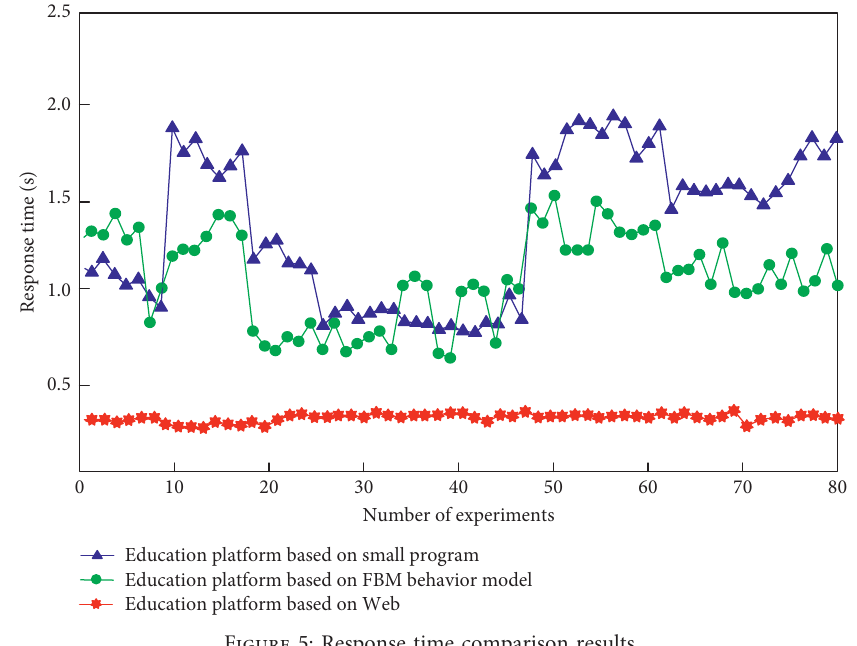
Figure 5: Response time comparison